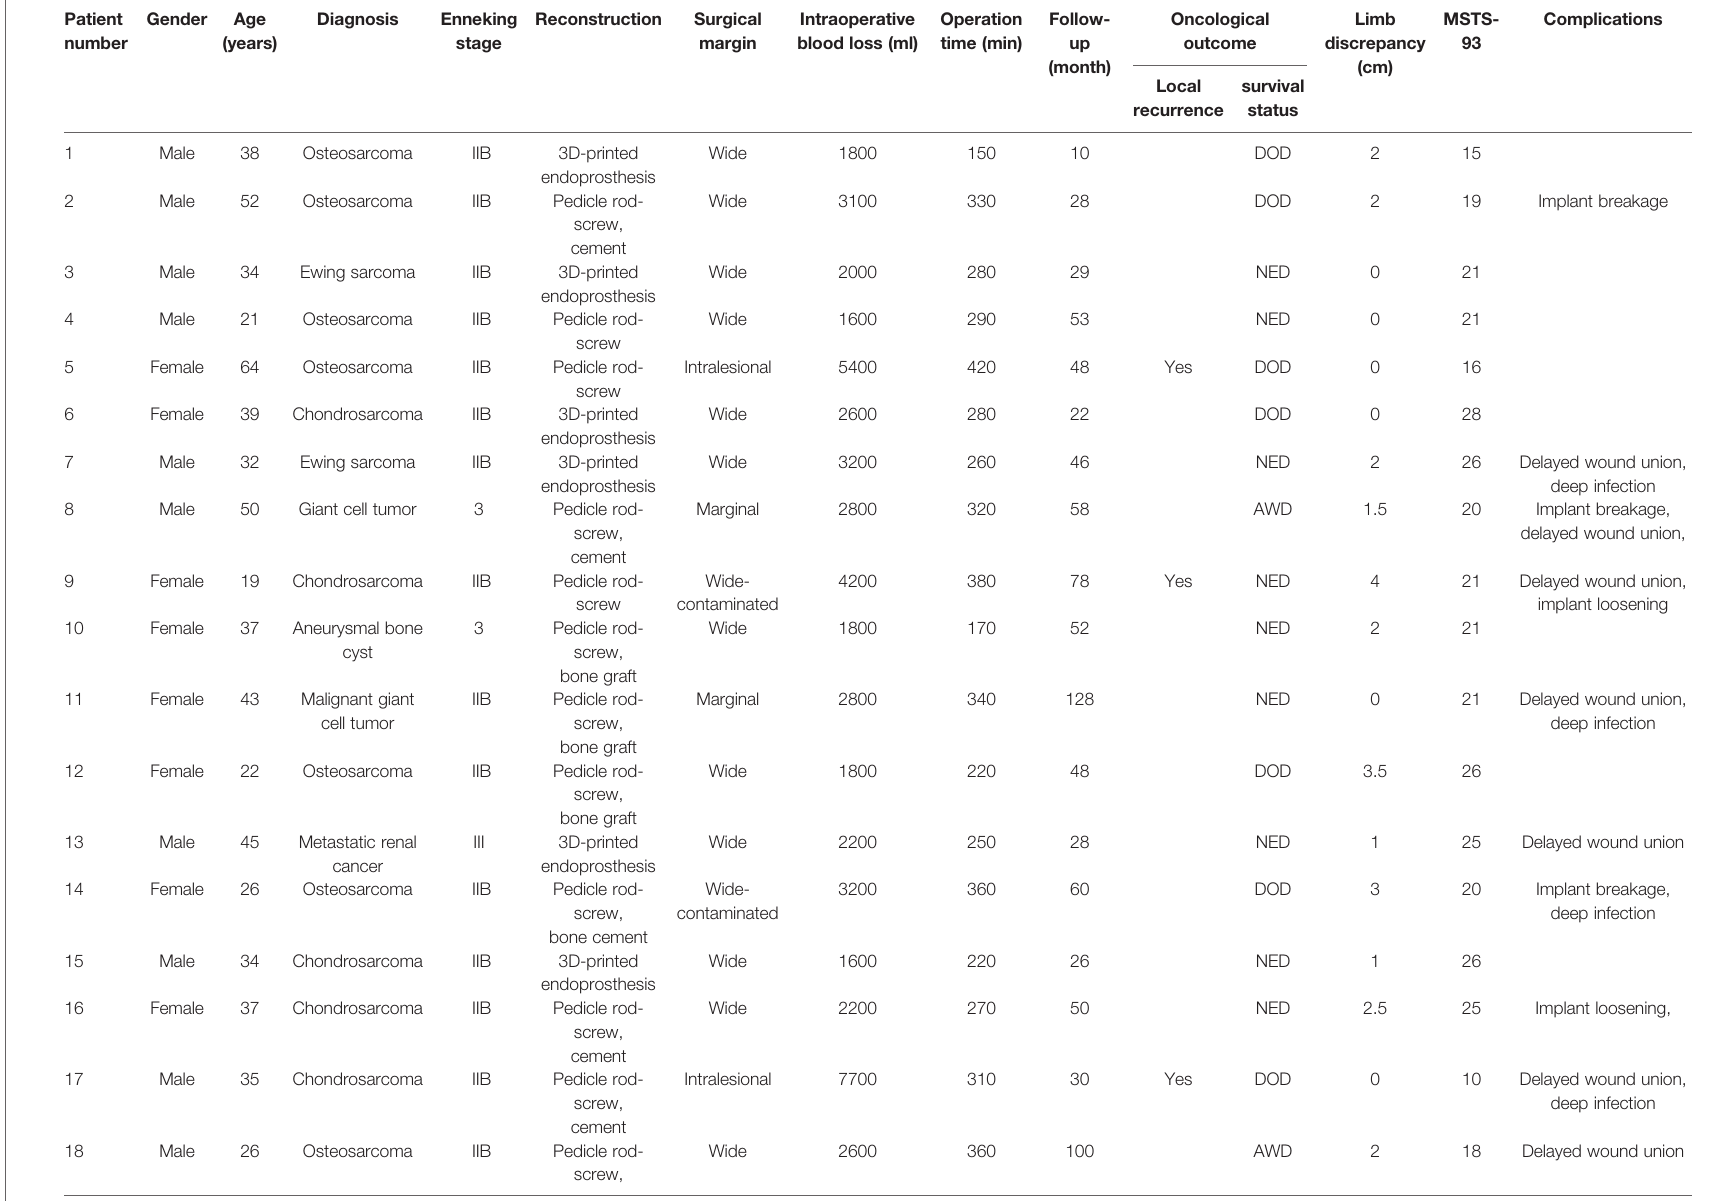
TABLE 1 | Demographics, clinical outcomes, and complications of the patients in this study. Patient number